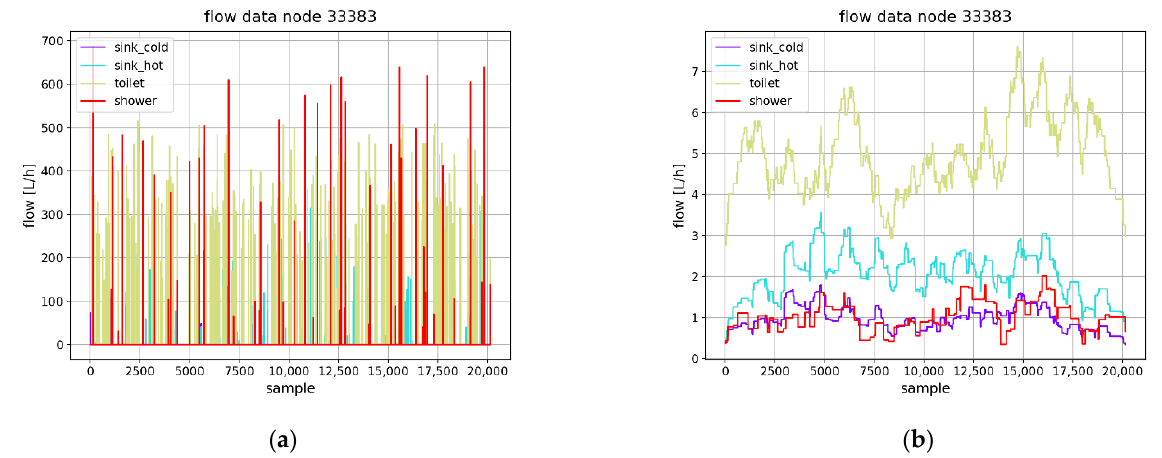
Figure 3. Sample data set for multisensor node: ( a ) raw data; ( b ) filtered data .